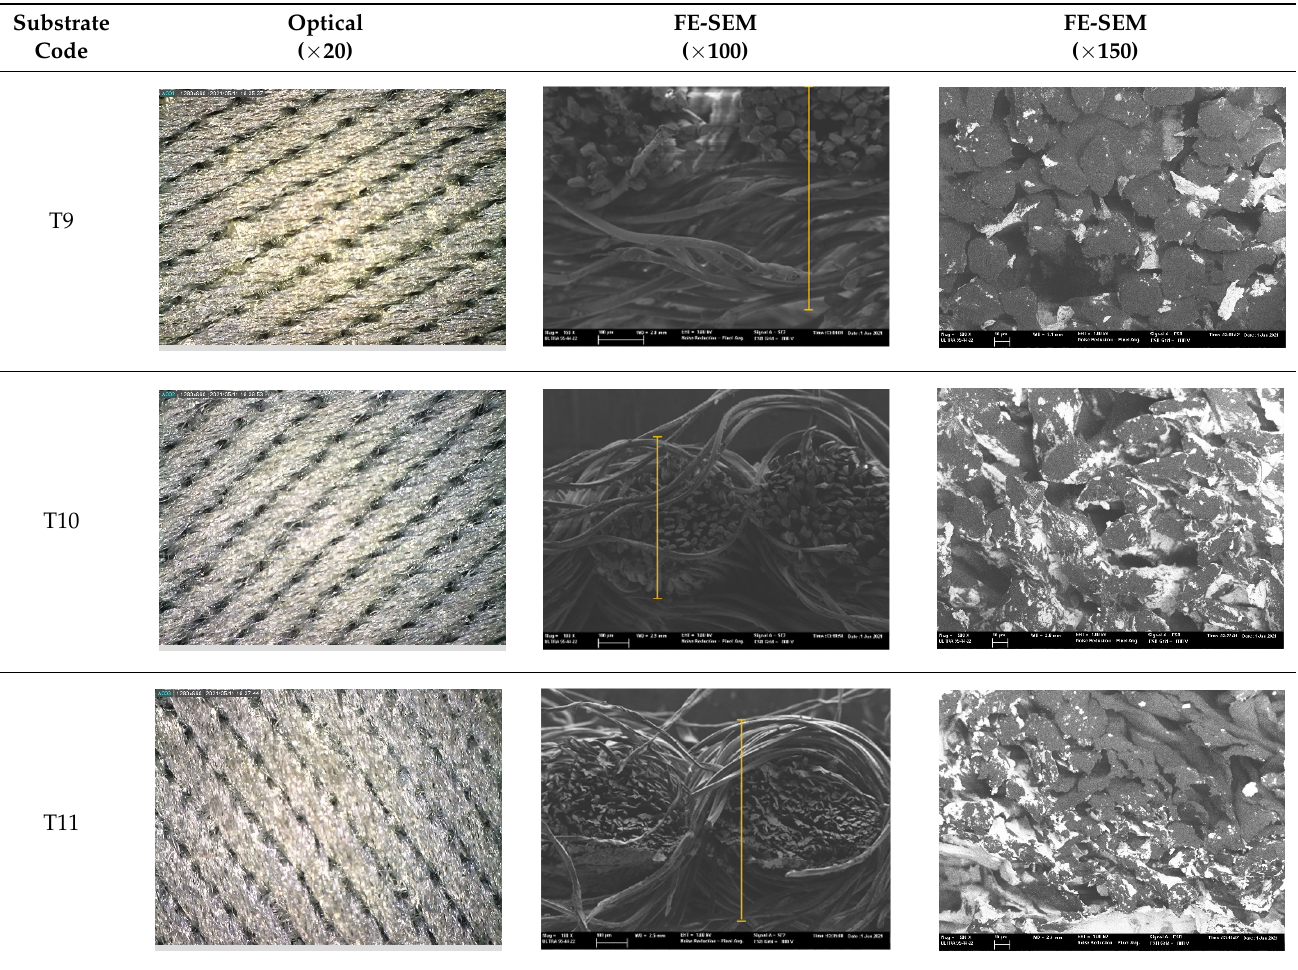
Table 7. Optical and FE-SEM characterization (II).